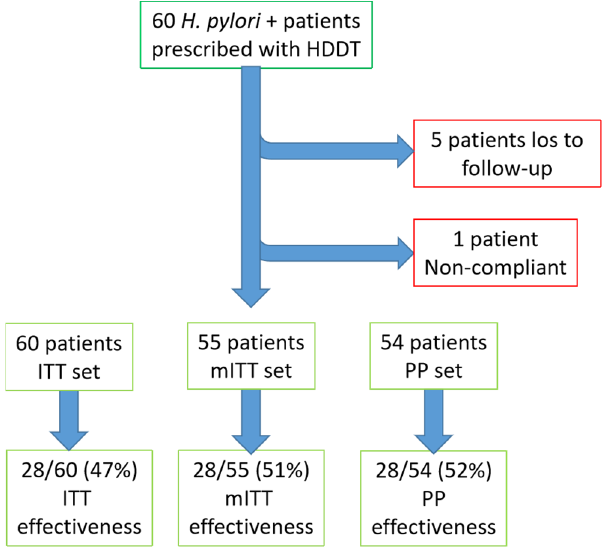
Figure 1. Study flowchart. HDDT, high-dose dual therapy; ITT, intention to treat; mITT, modified intention to treat; PP, per protocol. Table 2. HDDT effectiveness in first-line and as rescue